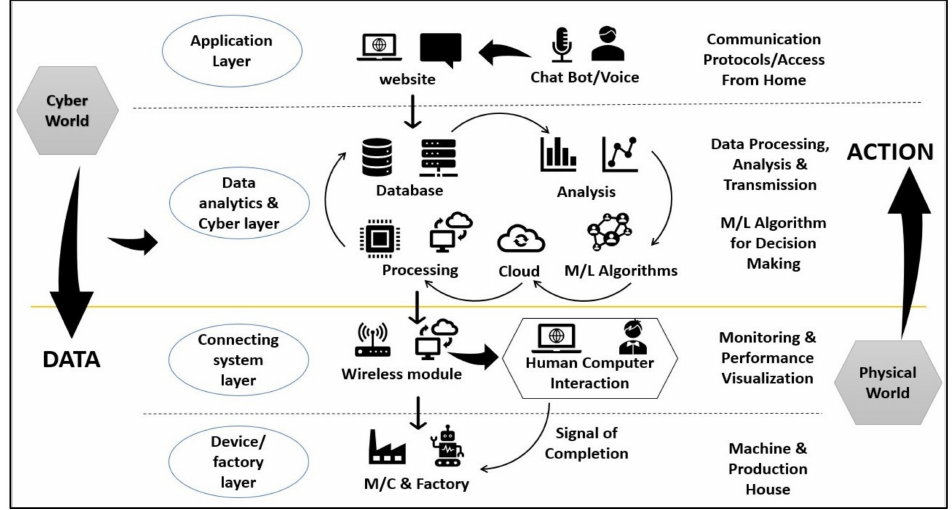
Figure 2. A layered view of the Internet of Things schematic for the Industry 4.0